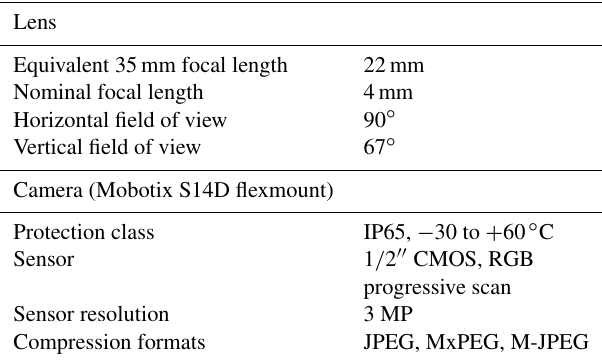
Figure 2. HaloCam: wide-angle camera (Mobotix S14D) with cir- cular shade on a sun-tracking mount. The mount consists of two axes with stepping motors to adjust azimuth and elevation of the camera. Table 1. HaloCam camera